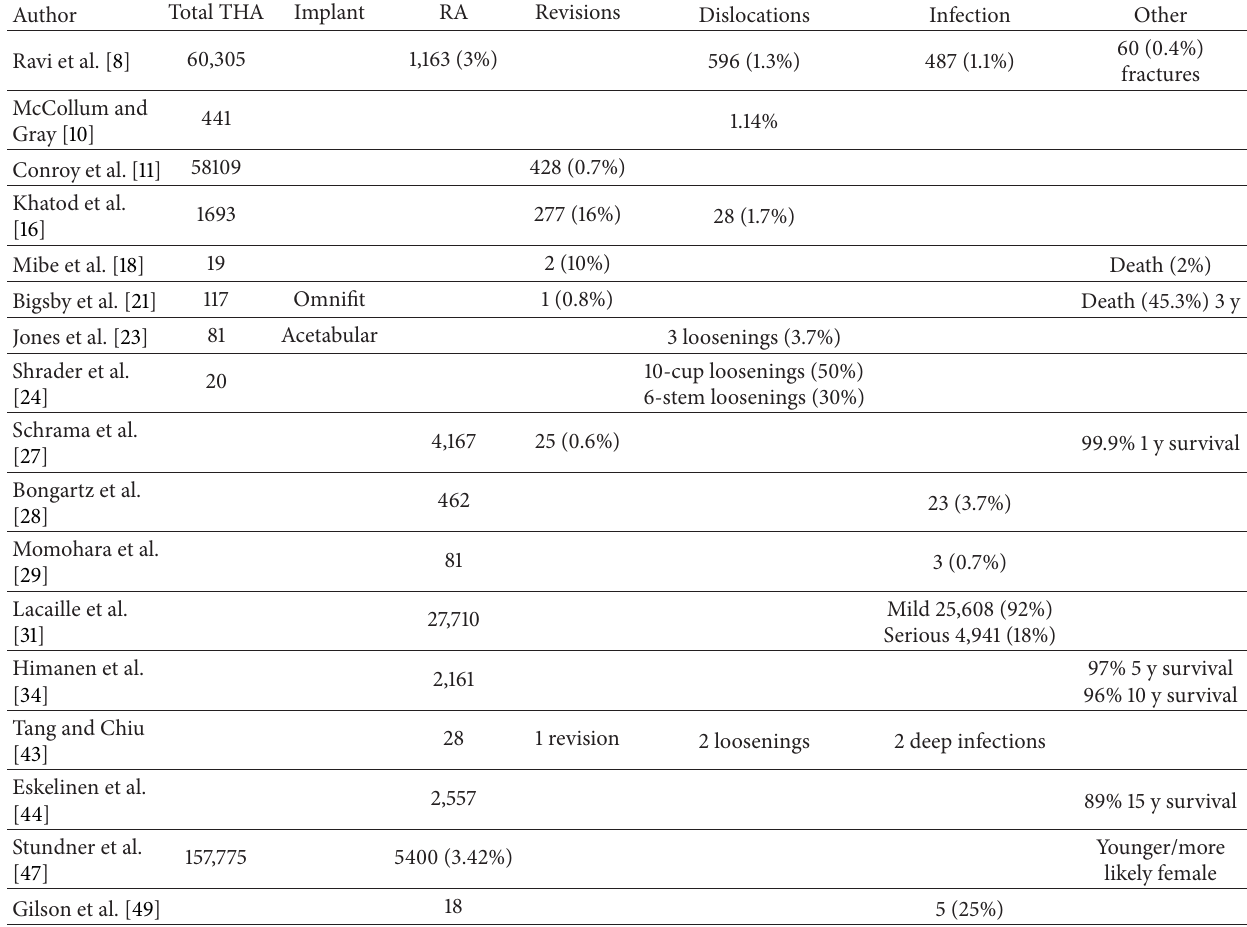
Table 1: Table showing rate of complications in RA patients undergoing